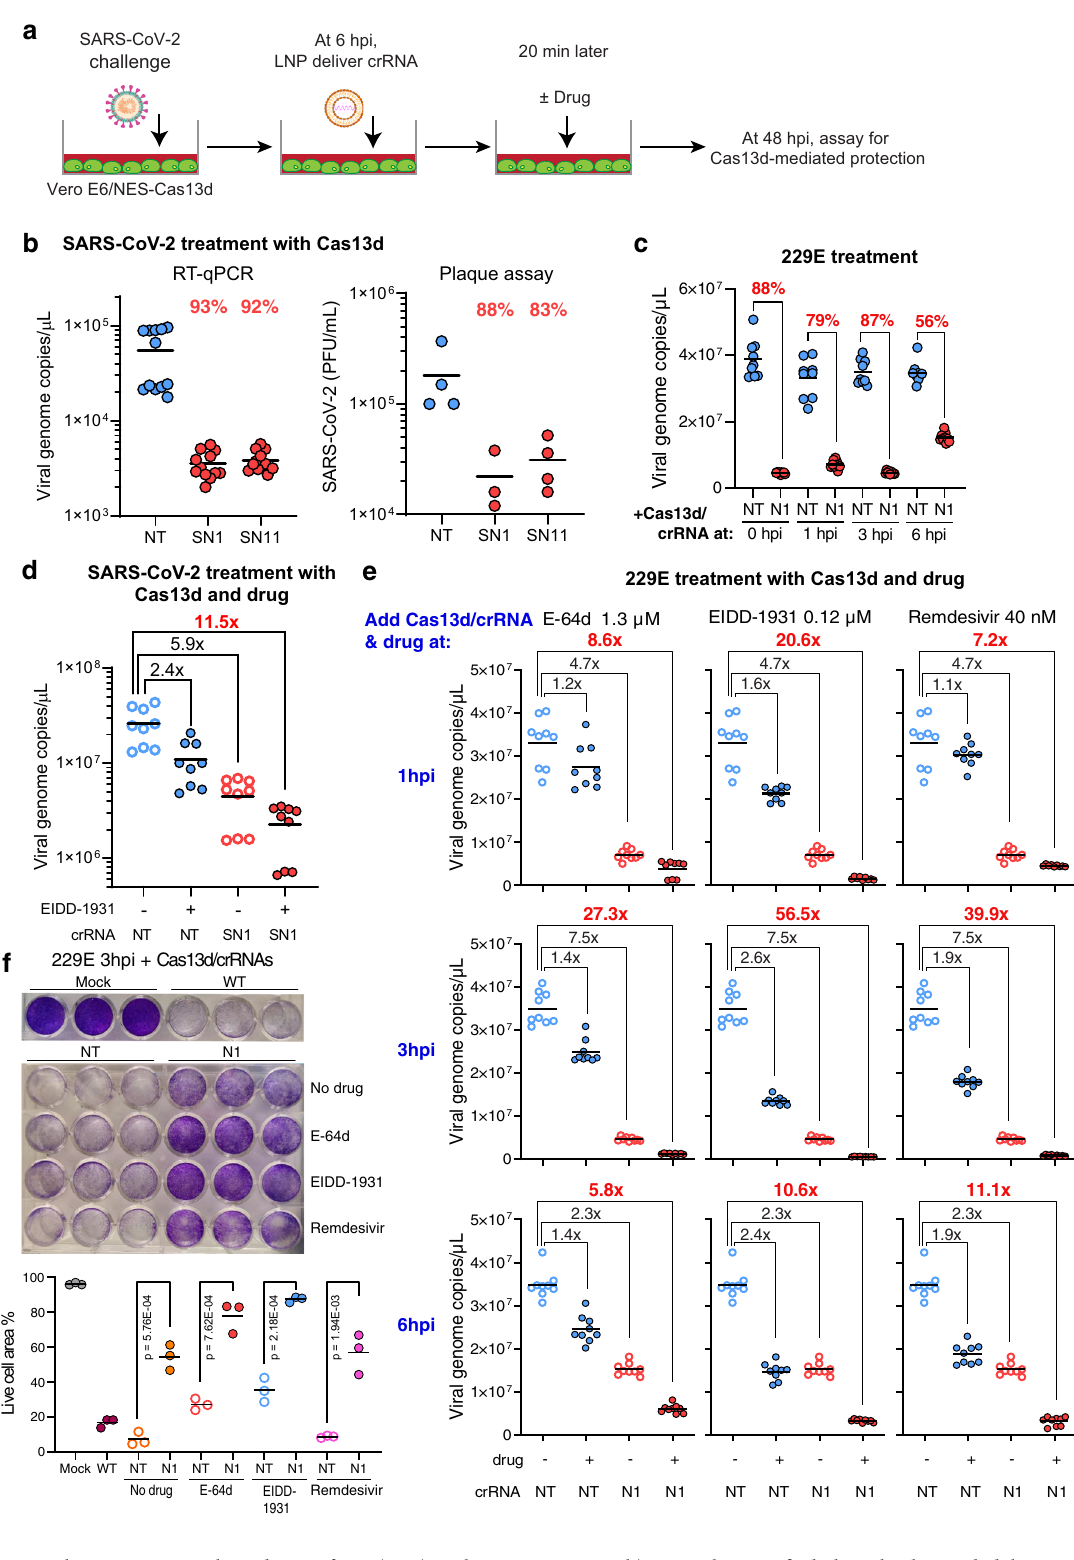
against virus replication in air – liquid interface (ALI) cultures derived from human primary bronchial epithelial cells (hPBECs). ALI cultures are an in vitro model of the human airway that can be expanded and differentiated into a pseudostrati fi ed epithelium that recapitulates the architecture and many of the cell types of the human lung 49 . We fi rst established that 229E and SARS-CoV- 2 can successfully replicate in ALI cultures (Supplementary